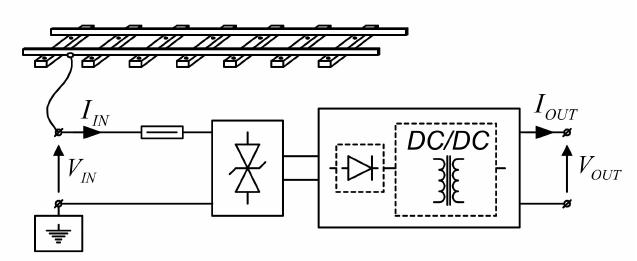
Figure 3. The basic architecture of EH